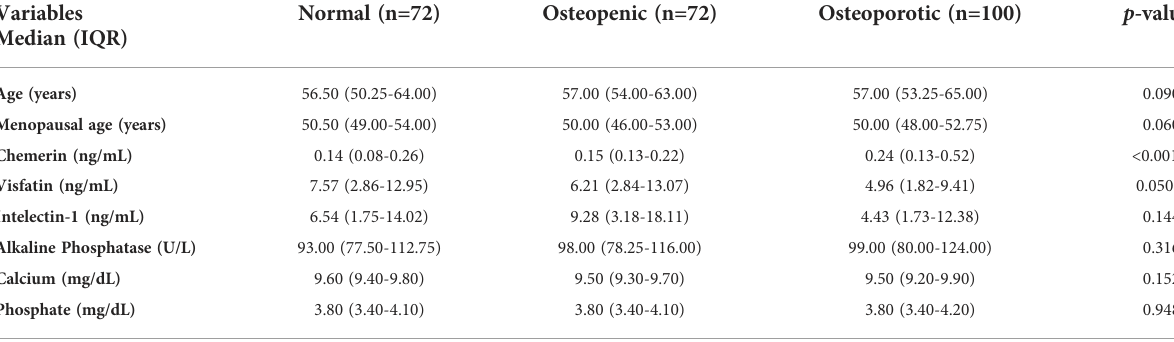
TABLE 1 Comparison of general characteristics and biochemical parameters of the study